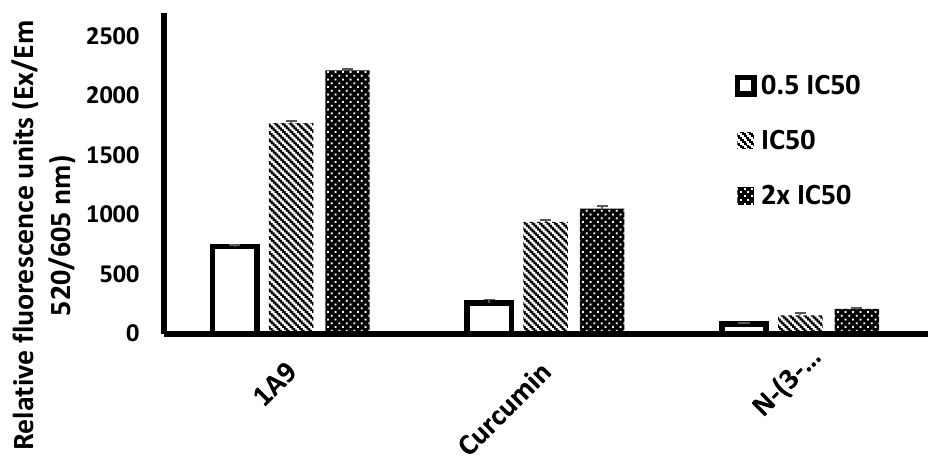
Figure 7. Generation of reactive oxygen species in CCRF ‐ CEM cells by curcumin, N ‐ (3 ‐ nitro ‐ phenylpyrazole) curcumin, and 1A9. Cells were incubated with 0.5×, 1×, 2×, or 4× IC 50 and incubated at 37 °C for 24 h. DMSO was used as vehicle control. Mean ± SD of three independent measurements.